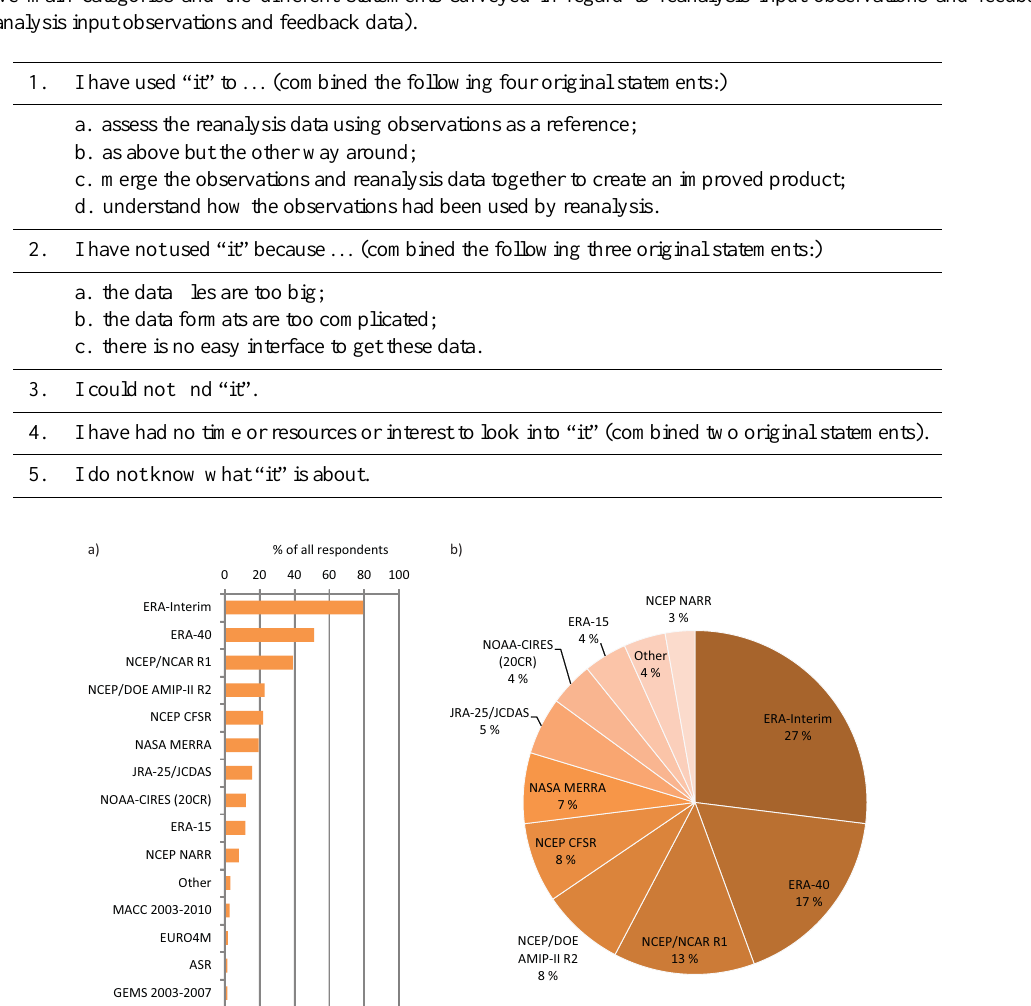
Table 1. The five main categories and the different statements surveyed in regard to reanalysis input observations and feedback data (“it” refers to reanalysis input observations and feedback data).